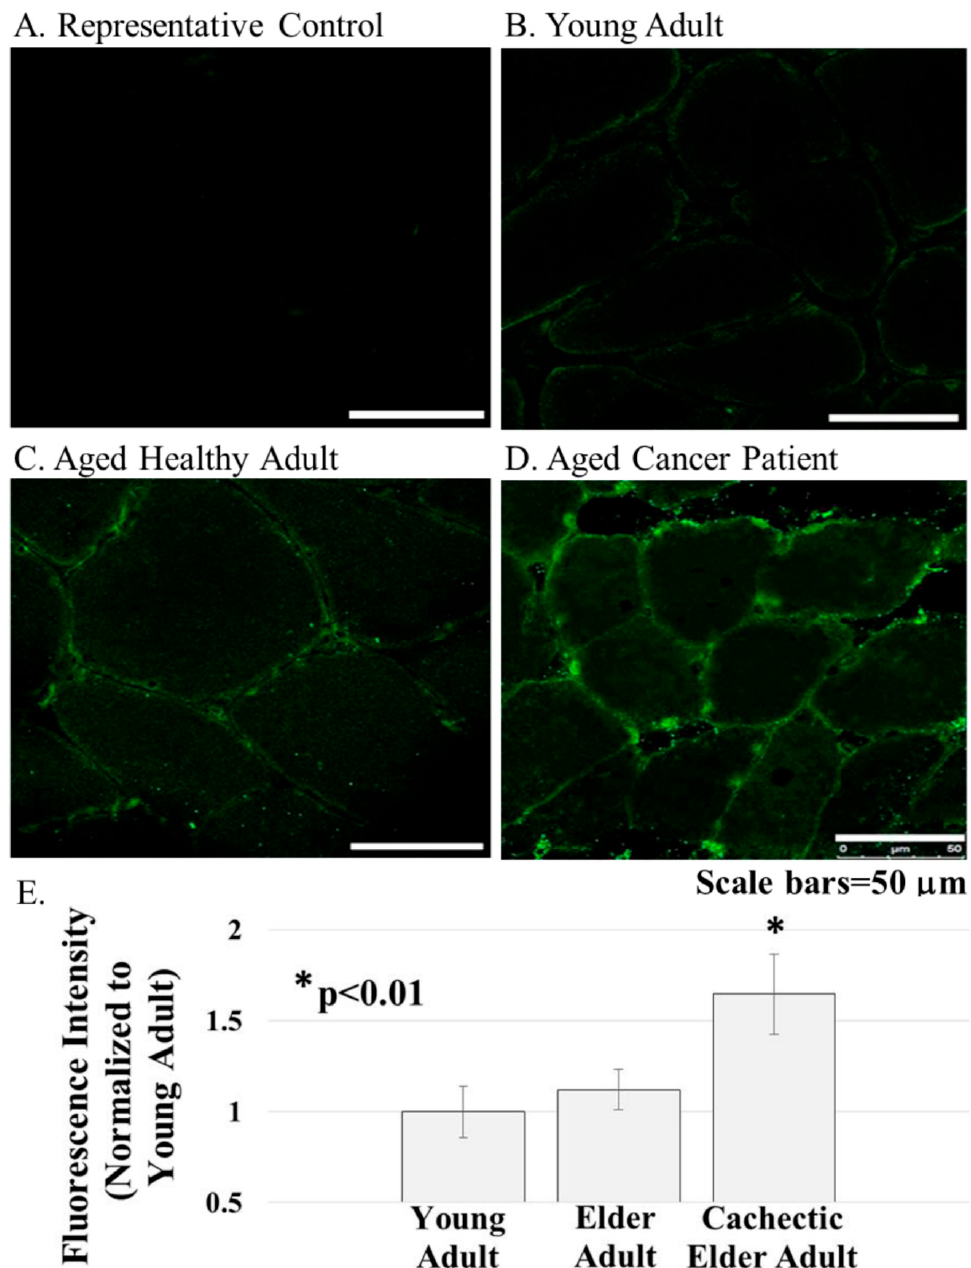
Figure 3. ERG1 protein was detected in cross-sections of the human Rectus abdominis muscle by fluorescent immunohistochemistry. ( A ) Fluorescence was absent from control sections immunostained without primary antibody; ( B – E ) The ERG1 fluorescence was greater in the skeletal muscle from elder cancer patients (( D ), n = 5) than in that of healthy aged-matched (( C ), n = 7) or young adult (( B ), n = 4) humans. All samples were stained and imaged using the same parameters in a single setting. Scale bars are 50 μ m. E. ERG1 fluorescence is statistically more abundant in the skeletal muscle of elder cancer patients. Graph bars represent mean fluorescence intensity ± the standard error of the mean. The “*” designates a statistical difference ( p < 0.01). Images were acquired using a Leica DM4500 microscope with a Leica DFC 340FX camera.